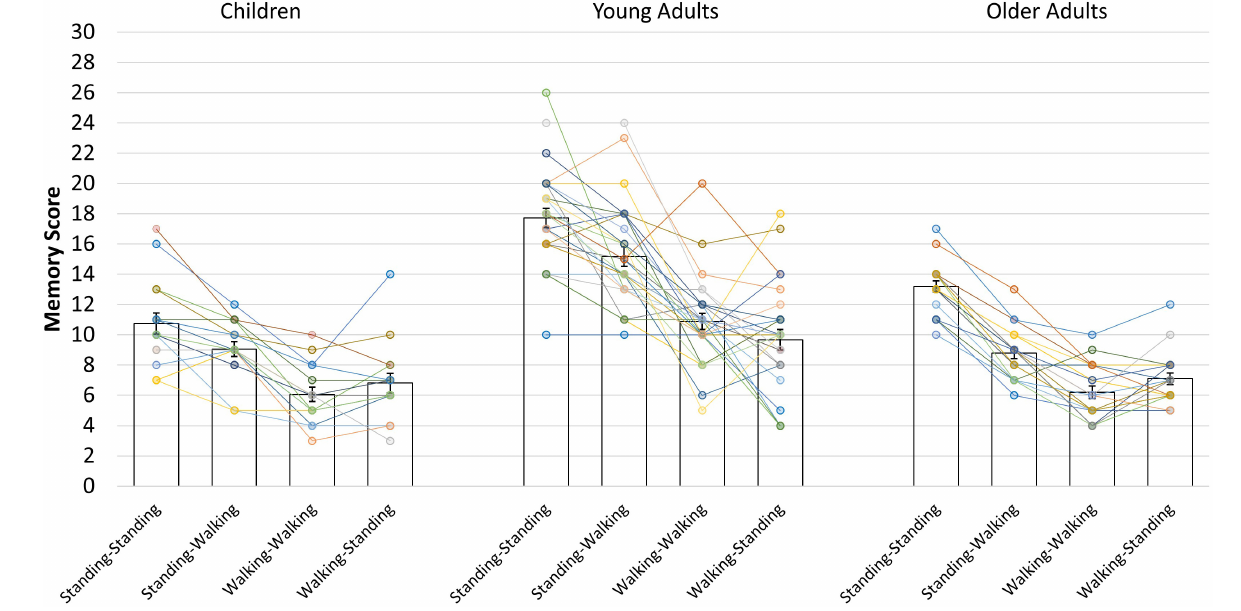
and episodic memory (Dijkstra et al., 2007; So et al.,